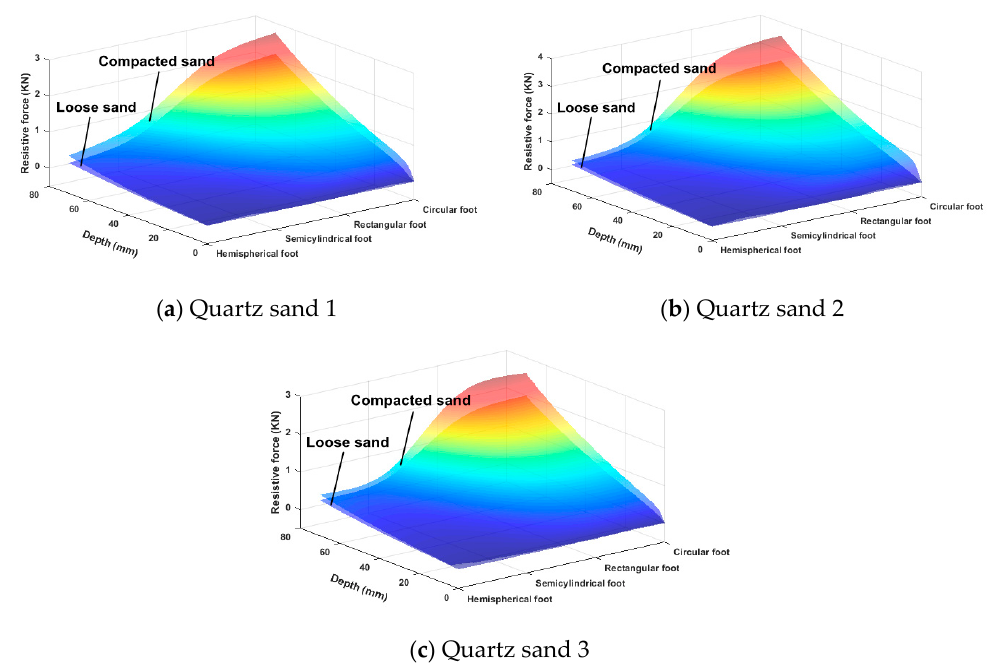
Figure 11. E ff ect of sand compact degree on the intrusion resistive